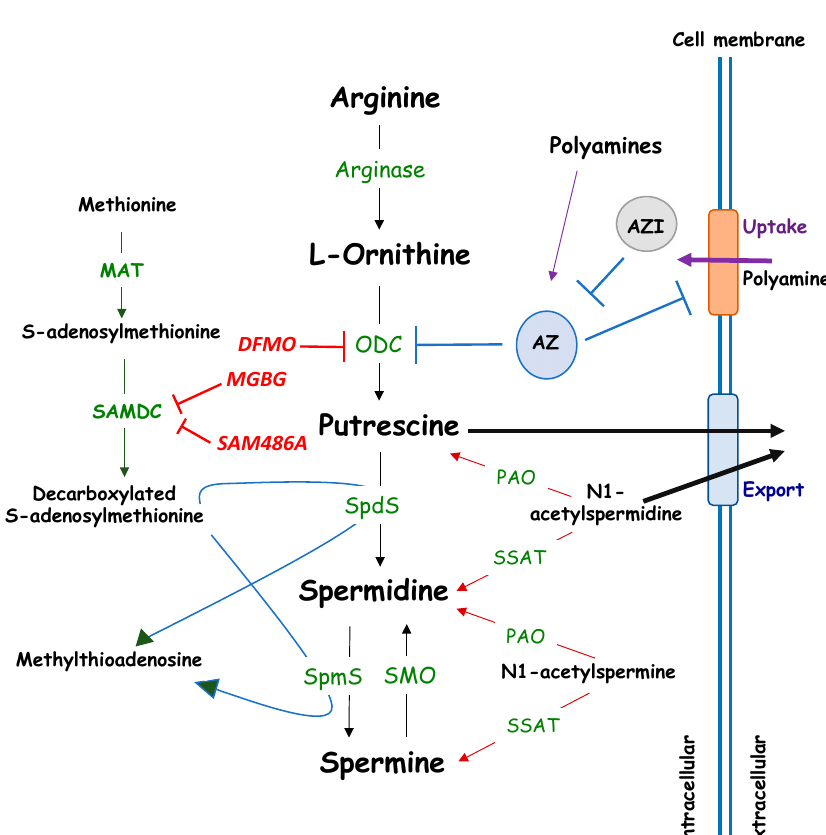
Figure 1. Metabolism of polyamines. MAT: Methionine adenosyl-transferase; ODC: Ornithine